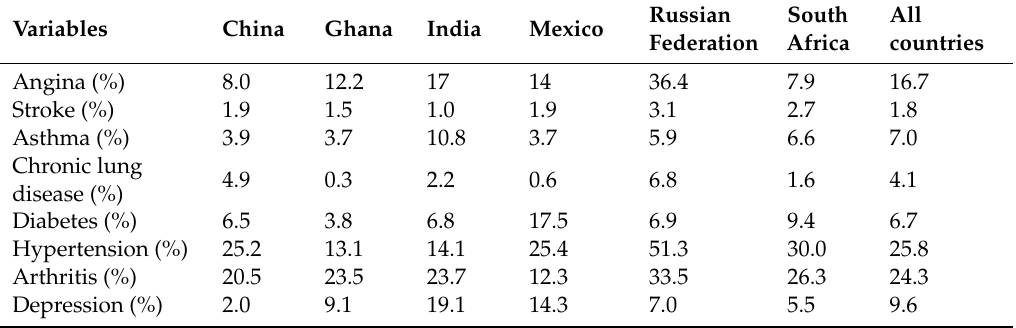
Table A1. Prevalence of chronic conditions among respondents aged 50 + , by country, WHO SAGE Wave